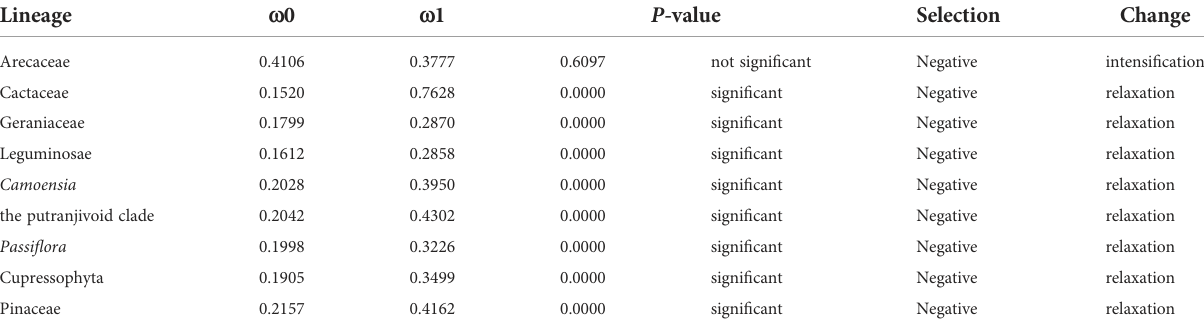
TABLE 2 Selectional strength and direction. w 0 indicates the result of the one-ratio model (all branches in the phylogenetic tree of this model are equal); w 1 indicates the result of the two-ratio